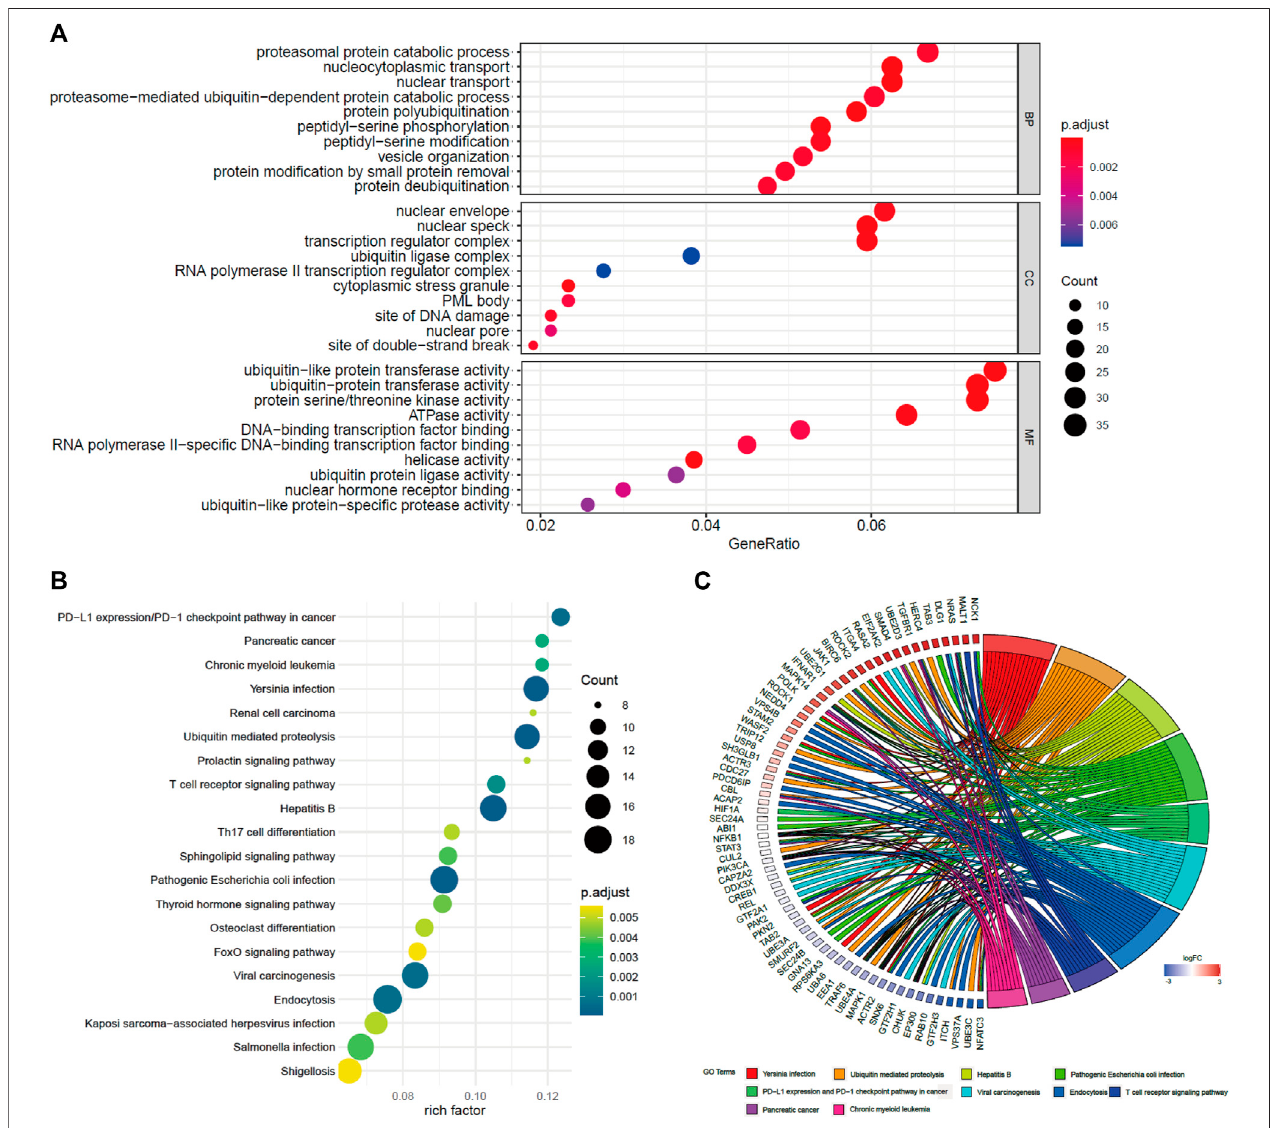
FIGURE6| GOandKEGGpathwayenrichmentanalysisofBACH1. (A) GOpathwayenrichmentanalysisofBACH1 (B) - (C) KEGGpathwayenrichmentanalysisof BACH1.